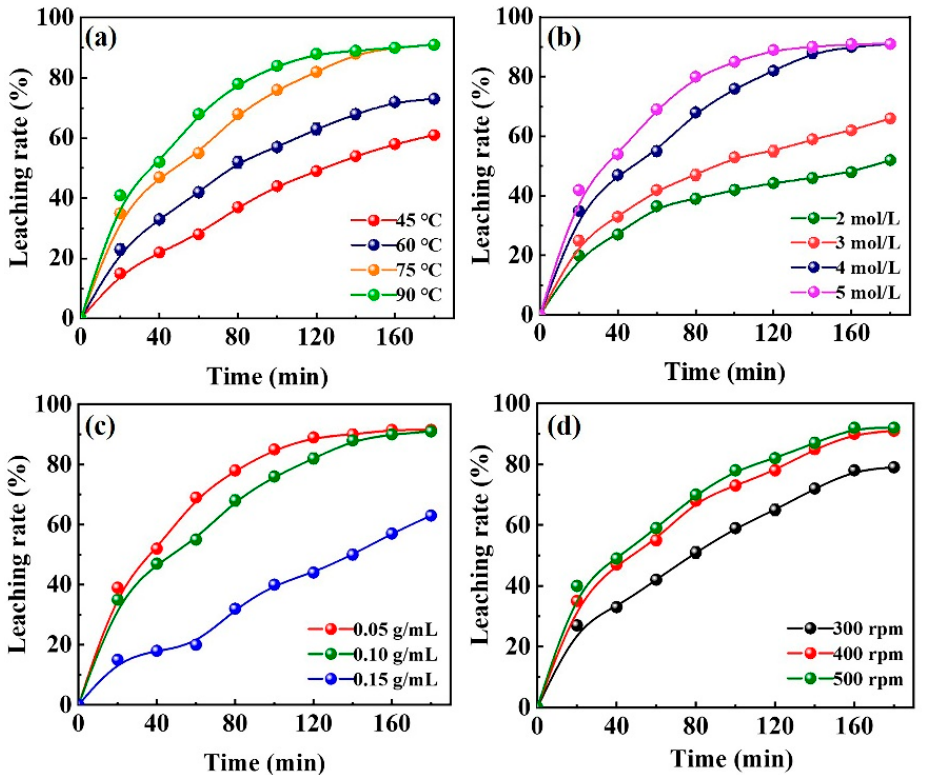
Figure 2. Effect of parameters on the leaching of Sn ( a ) temperature (4 mol/L HCl, 0.10 mg/L, 400 rpm), ( b ) HCl concentration (40 °C, 0.10 mg/L, 400 rpm), ( c ) solid–liquid ratio (40 °C, 4 mol/L HCl, 400 rpm), and ( d ) stirring speed (40 °C, 4 mol/L HCl, 0.10 mg/L).